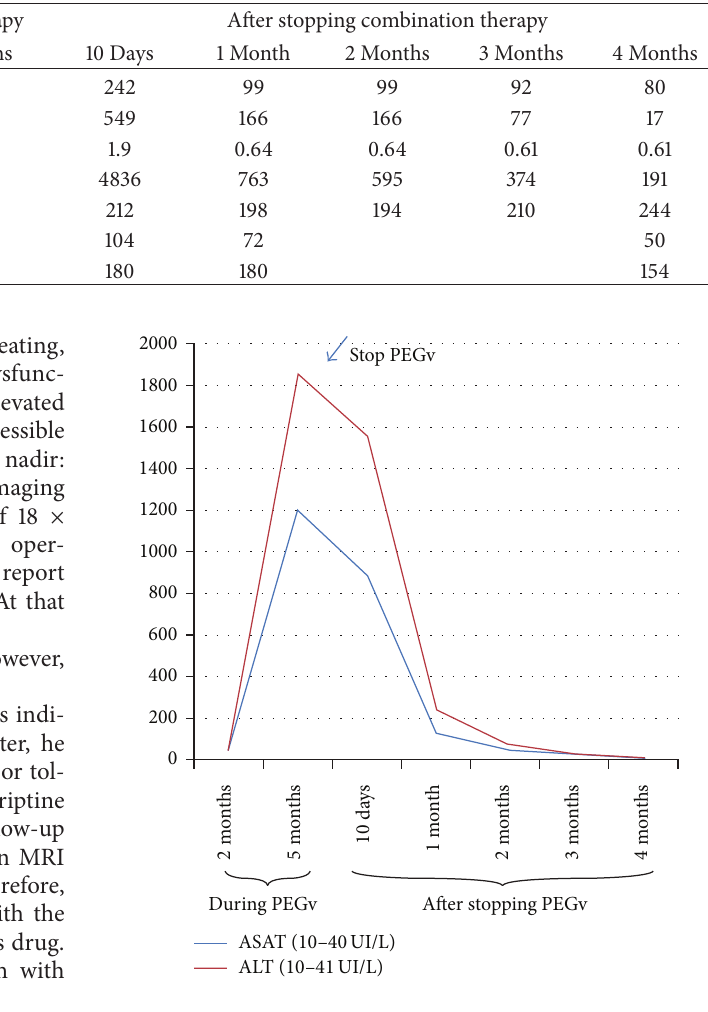
Figure 1: Chronological development of ASAT and ALT transami- nases during the combination therapy with PEGv and after stopping this treatment.